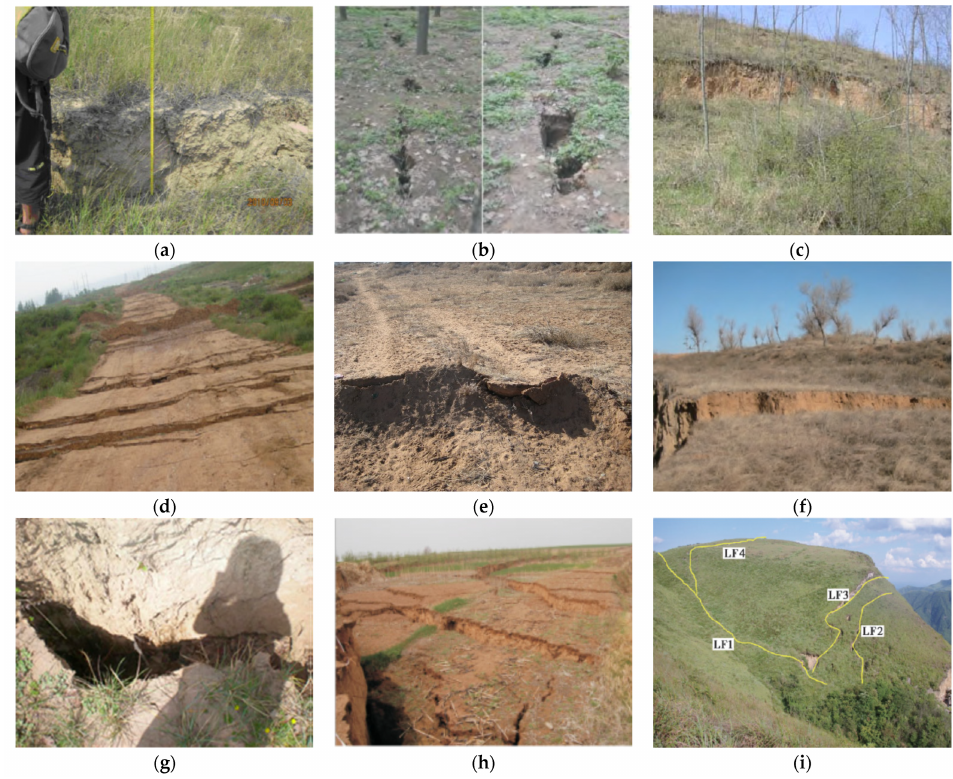
Figure 2. Mining ground fissure disasters in typical mining areas in China. ( a ) Huainan 8104 (Collapse fissure); ( b ) Pingdingshan 11022 (Stretch fissure); ( c ) Tongchuan D508 (Sliding fissure); ( d ) Shendong 12208 (Collapse fissure); ( e ) Shendong 22201 (Squeeze fissure); ( f ) Shendong 52304 (Sliding fissure); ( g ) Binchang B40301 (Stretch fissure); ( h ) Hezhai 2212 (Collapse fissure); ( i ) Jieniangping (Collapse and Sliding